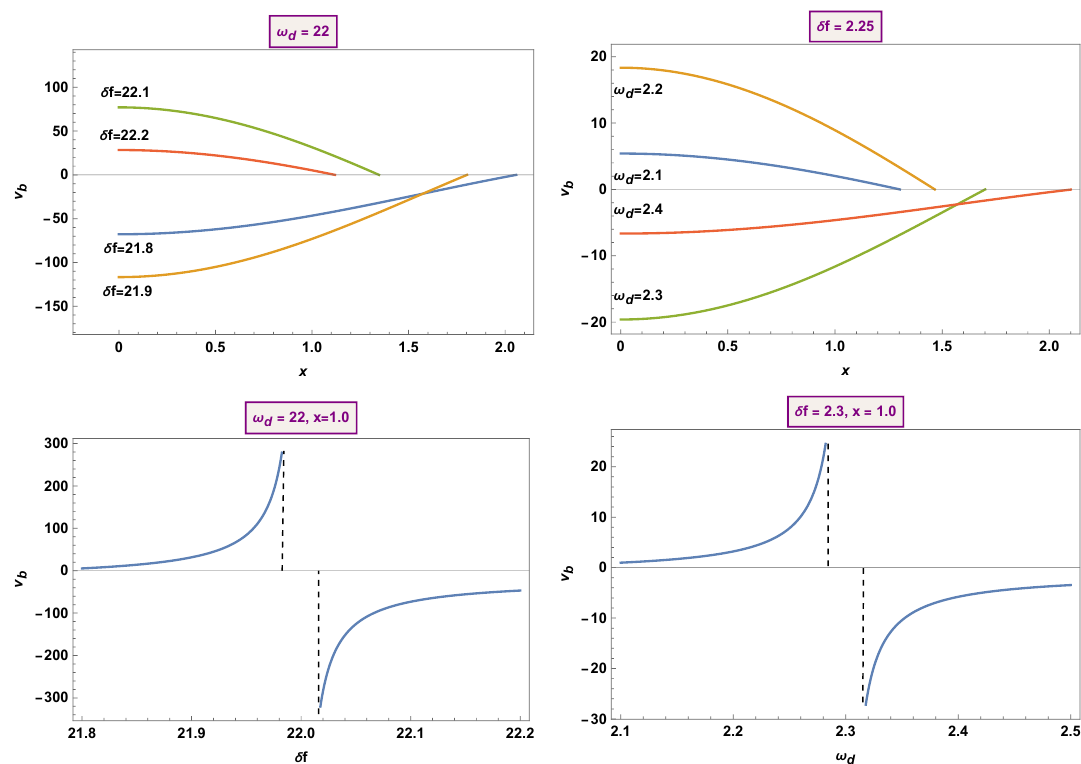
Figure 2 . Top left panel: spatial variation of the butterfly velocity v B ( x ) as a function of x and several δf for ω D = 2 π/T = 22 . The end points of the curves indicate the range of x where v B ( x ) can be defined. Top right panel: same as the top left panel but for different ω D and δf = 2 . 25 . Bottom left panel: plot of v B at x = 1 for as a function of δf for ω D . The dashed lines are schematic guide to the eye representing lines near ω D = δf where cη ’ 24 πh w . Bottom right panel: a similar plot as the left panel but as a function of ω D and for δf = 2 . 3 . All distances are scaled in units of L and all energies are scaled in units of 2 π . The drive amplitude is set to f 1 = 10 for all 2 π L